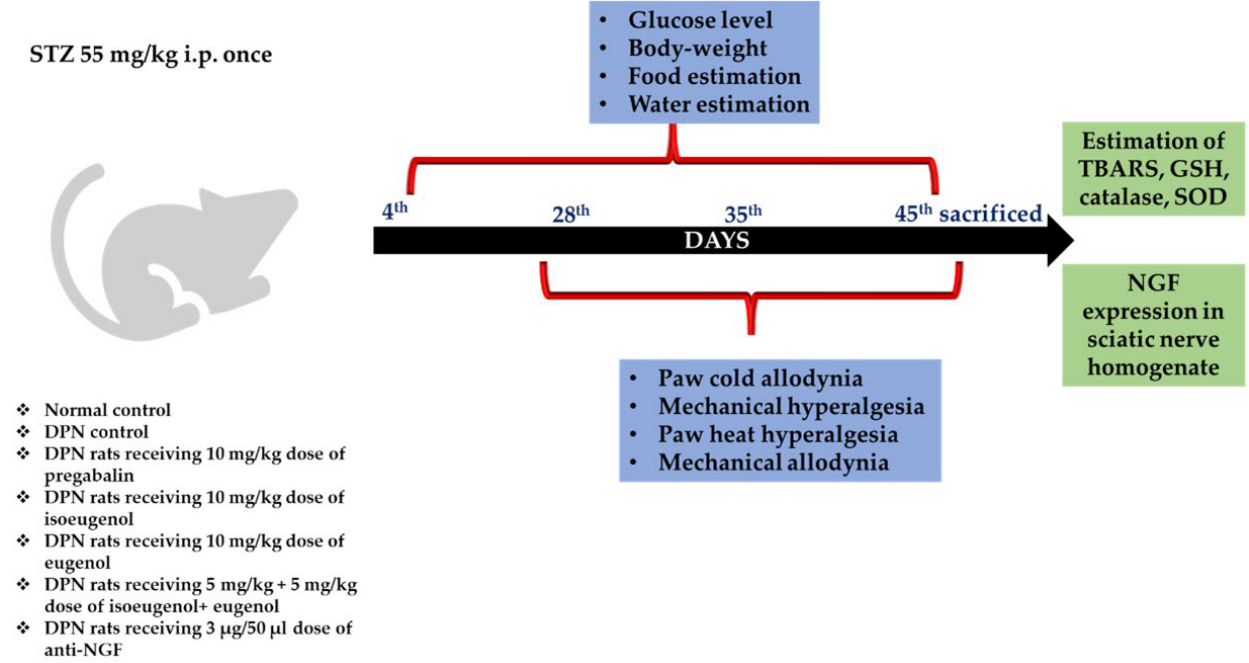
Figure 1. Experimental design .